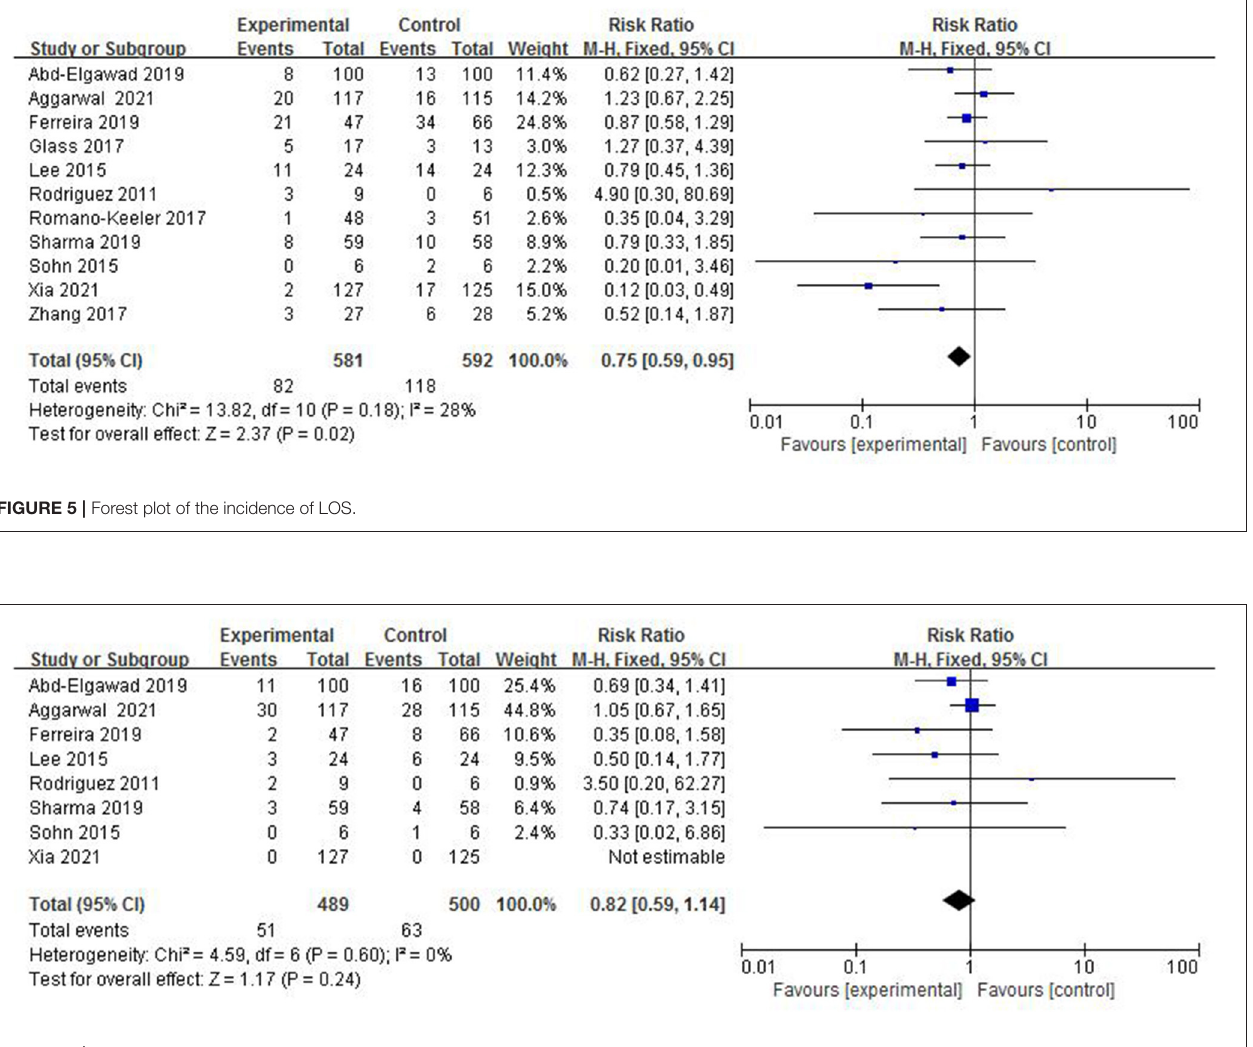
FIGURE 6 | Forest plot of the death before discharge to home.